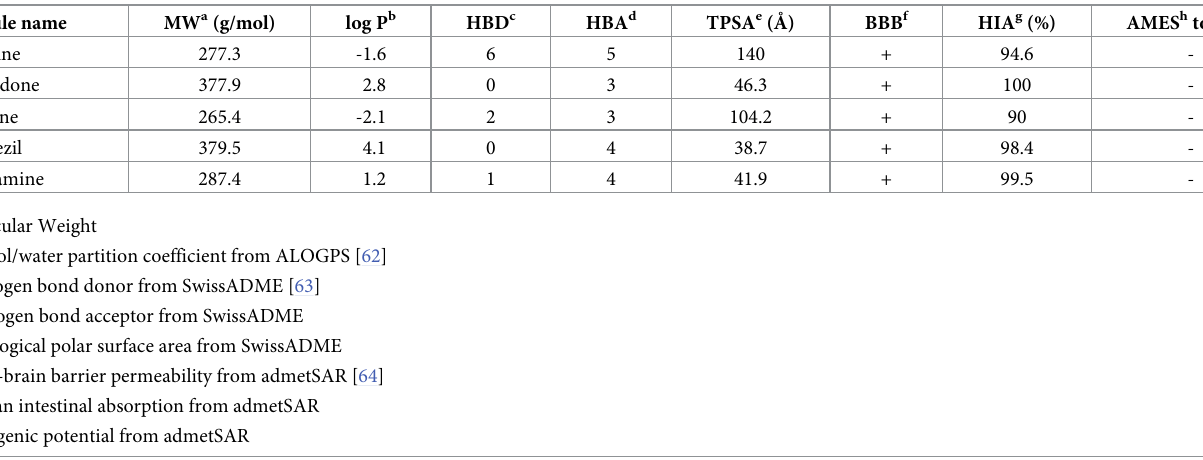
Table 4. Predicted druglike and ADMET properties of hit natural AChE inhibitor molecules compared to donepezil and